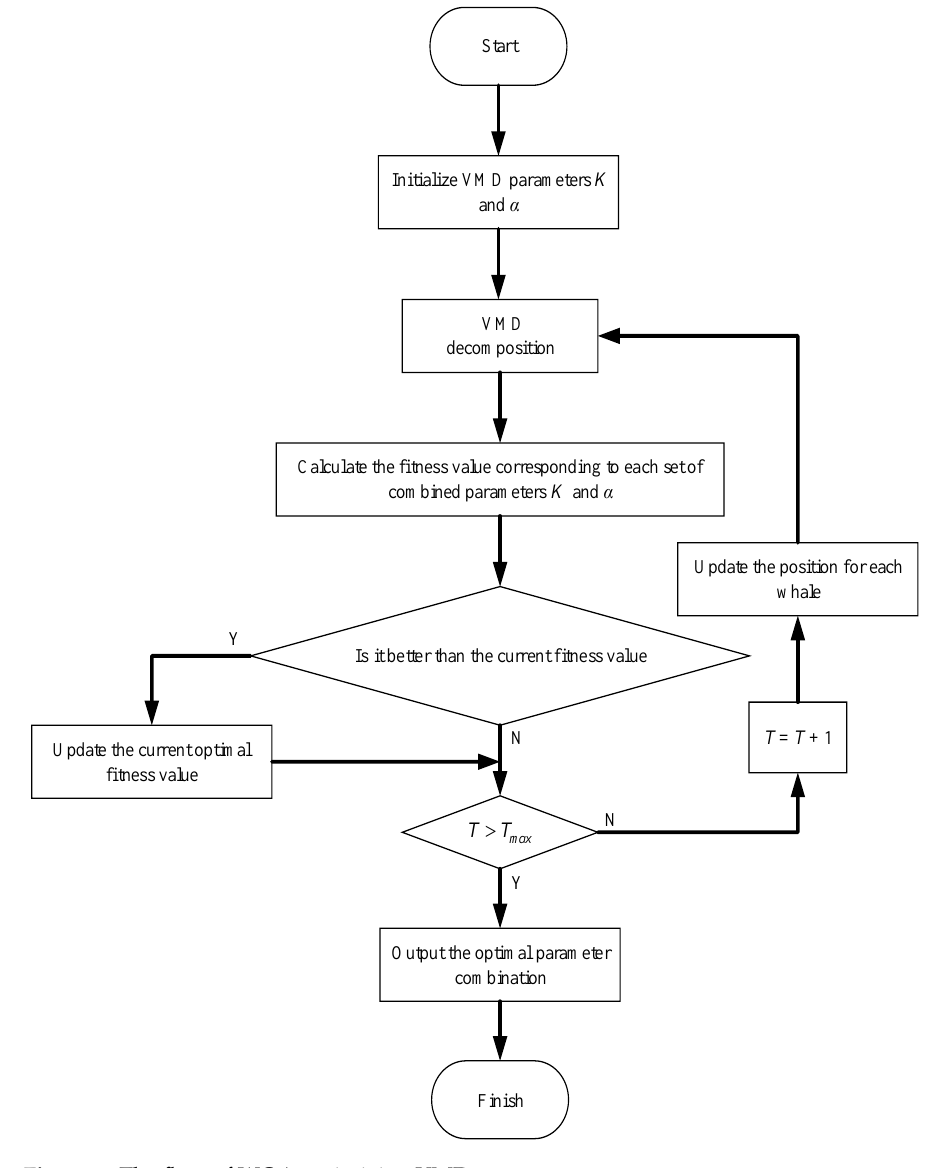
Figure 1. The flow of WOA optimizing VMD.